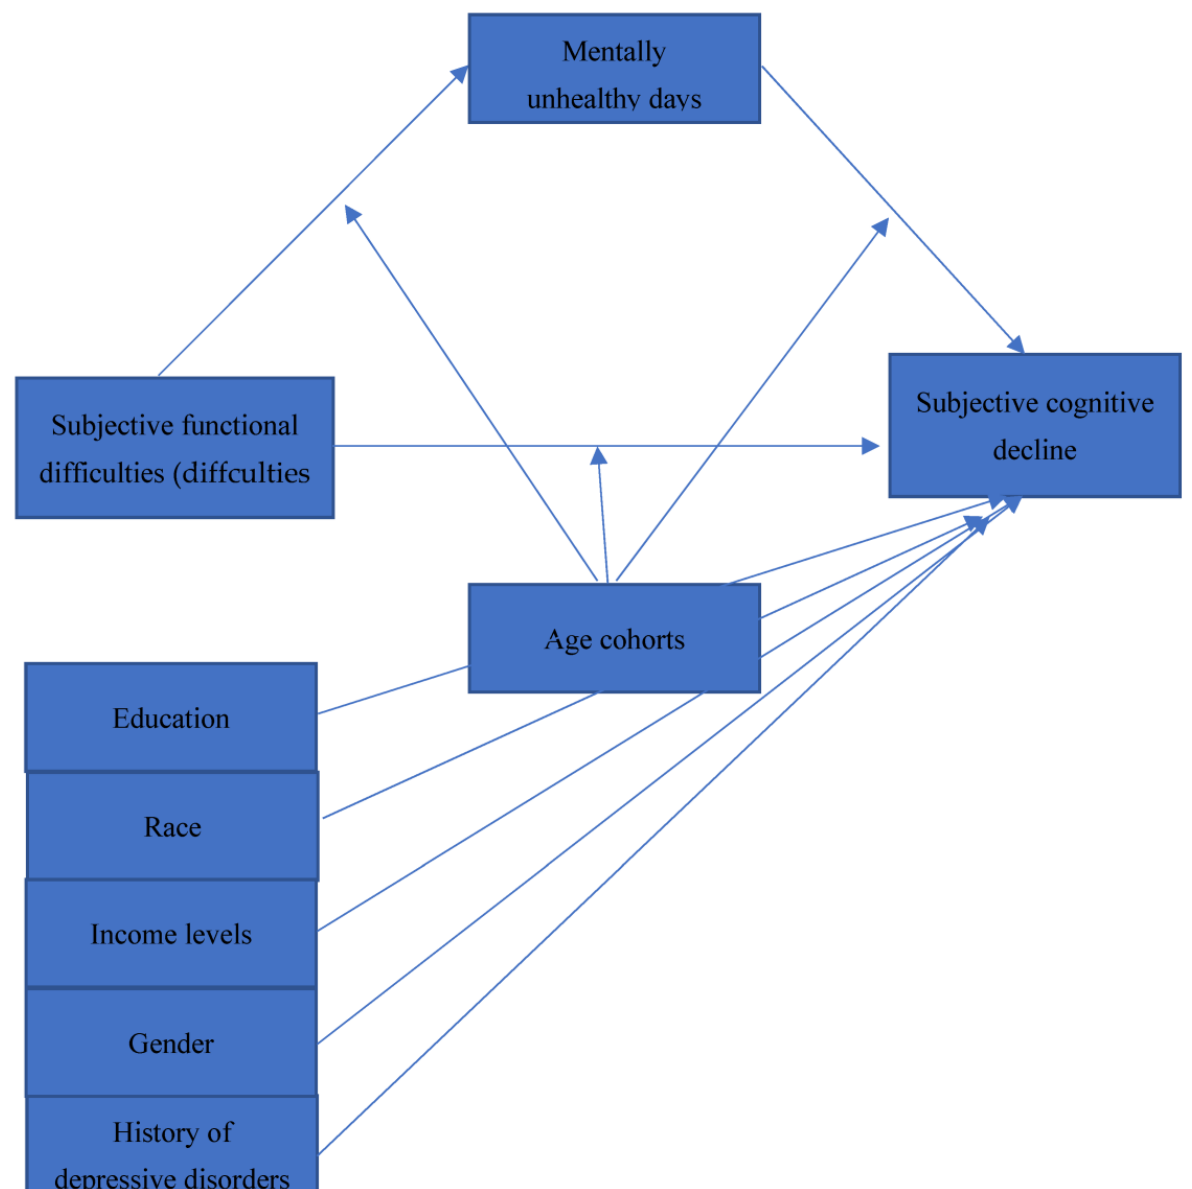
Figure 1. The conceptual framework of the moderated mediation model of the effect of mentally unhealthy days on SFD and SCD, controlling a history of depressive disorders, gender, education, income levels, and race. SCD, subjective cognitive decline; SFD, subjective functional difficulties).